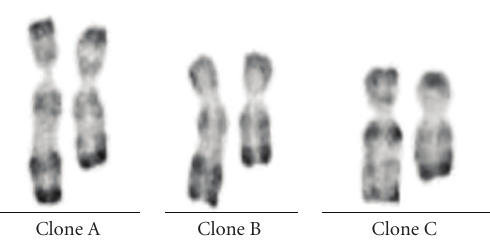
Figure 4: RHG banding of chromosomes 5 in a patient with three di ff erent